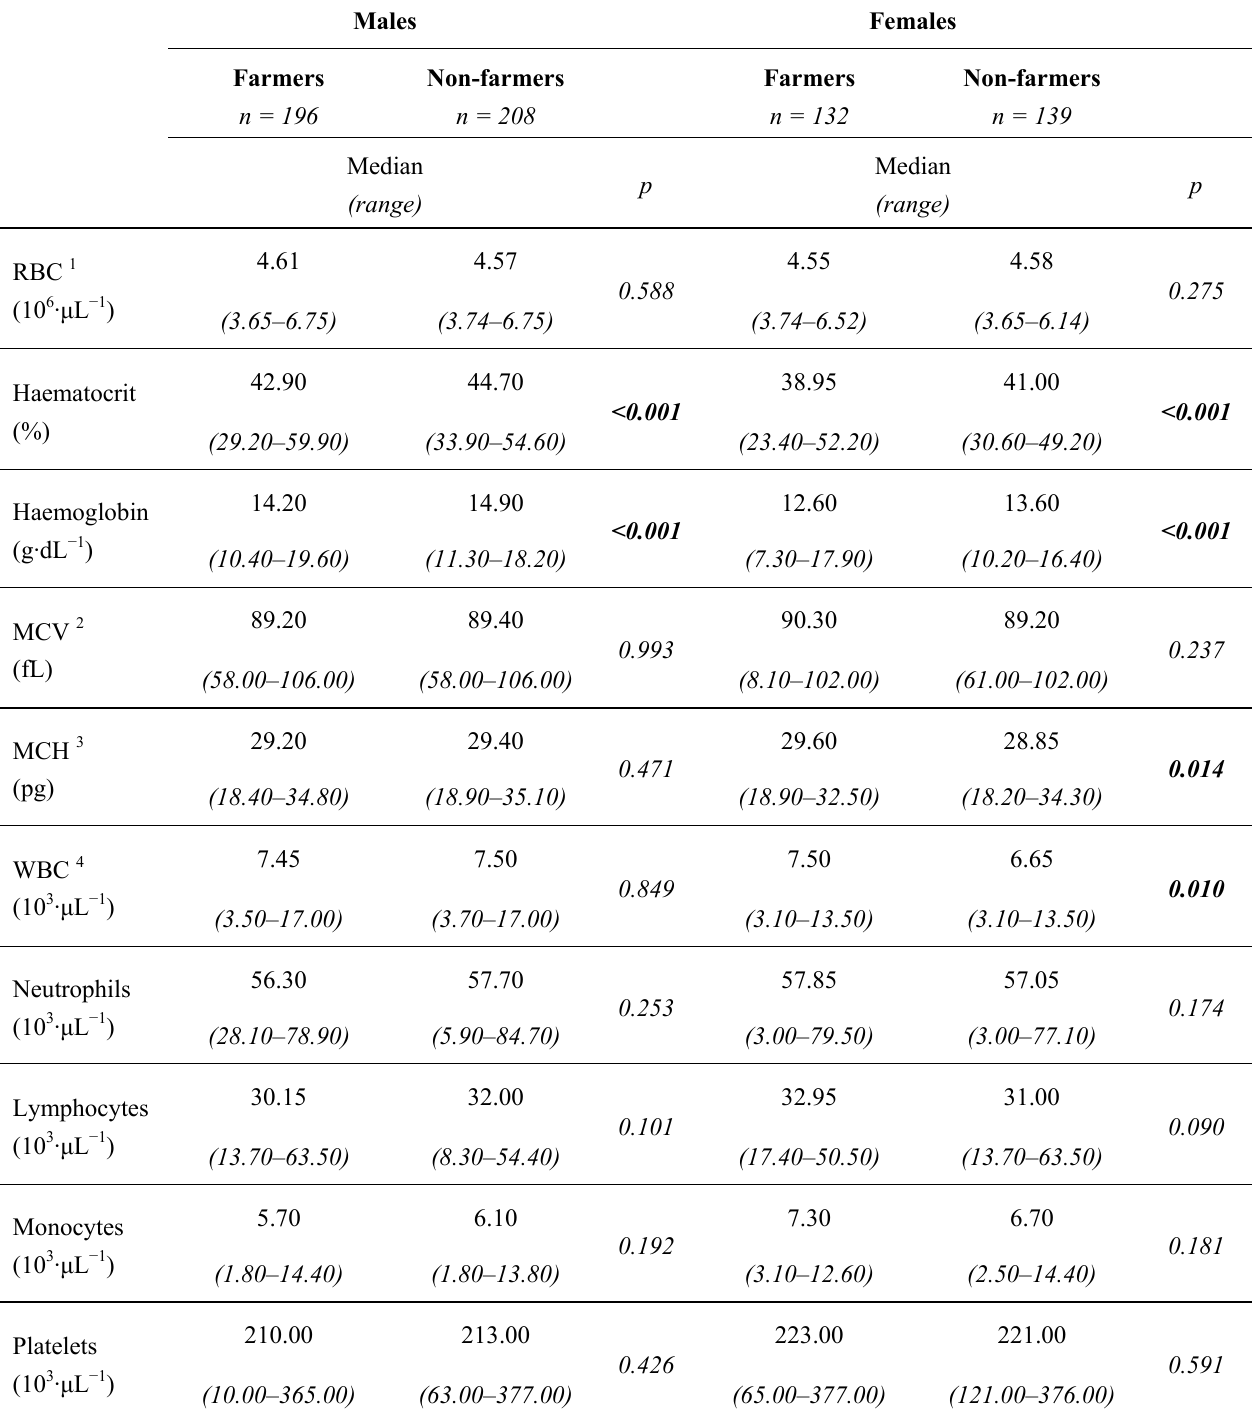
Table 3. Haematological blood